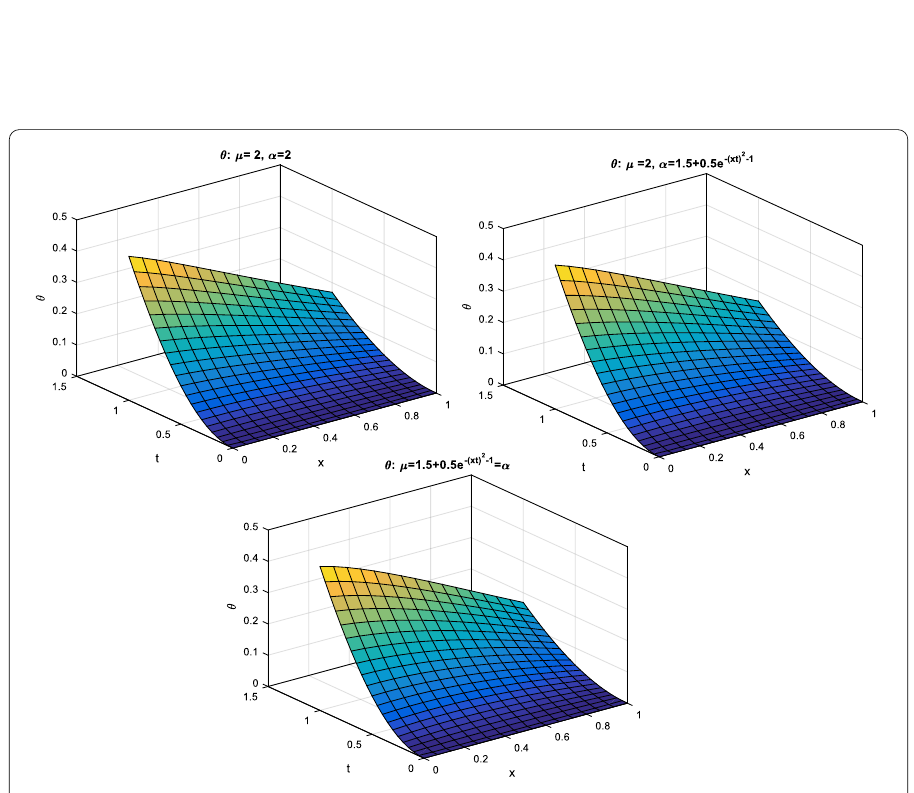
Figure 3 Comparison of the numerical solutions using the introduced method in Example 1 for different values of μ ,